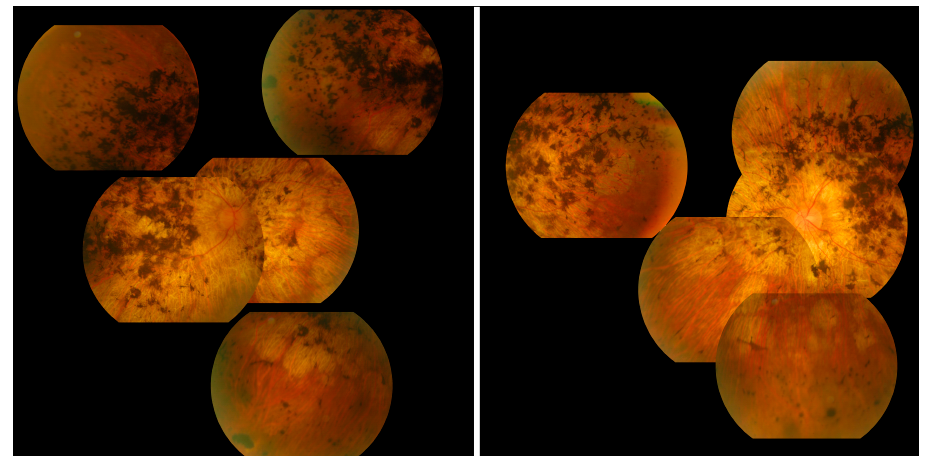
Figure 3. A summary of the genetic architecture of retinitis pigmentosa (RP) in Target 5000 participants (Table S4).